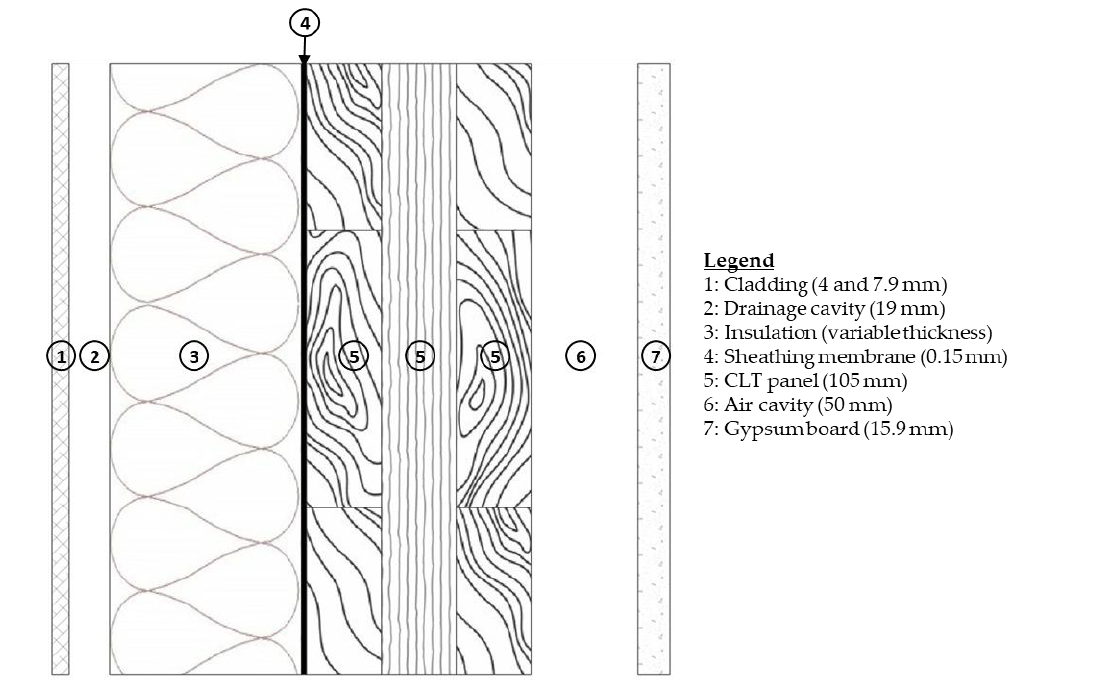
Figure 1. One dimensional configuration of the cross-laminated timber wall investigated in this study.